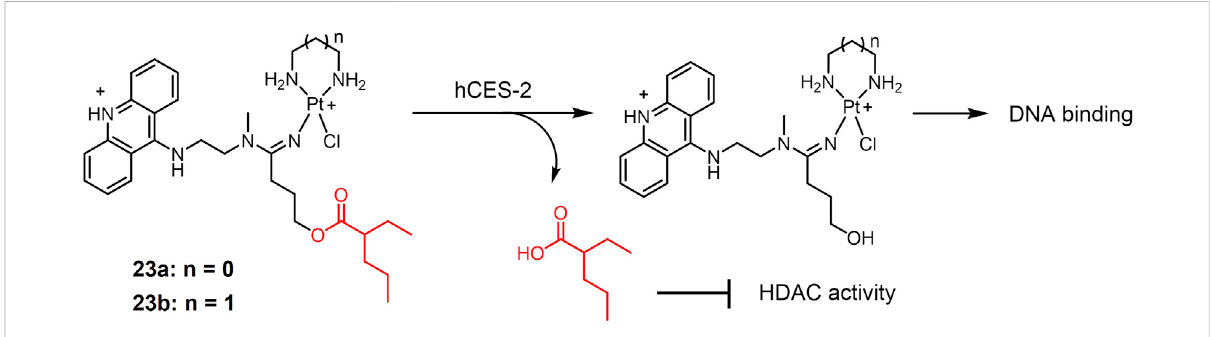
FIGURE 5 Human carboxylesterase-2 (hCES-2)-responsive Pt(II) prodrugs undergoing enzymatic cleavage to release active Pt(II) drugs and valproate as an